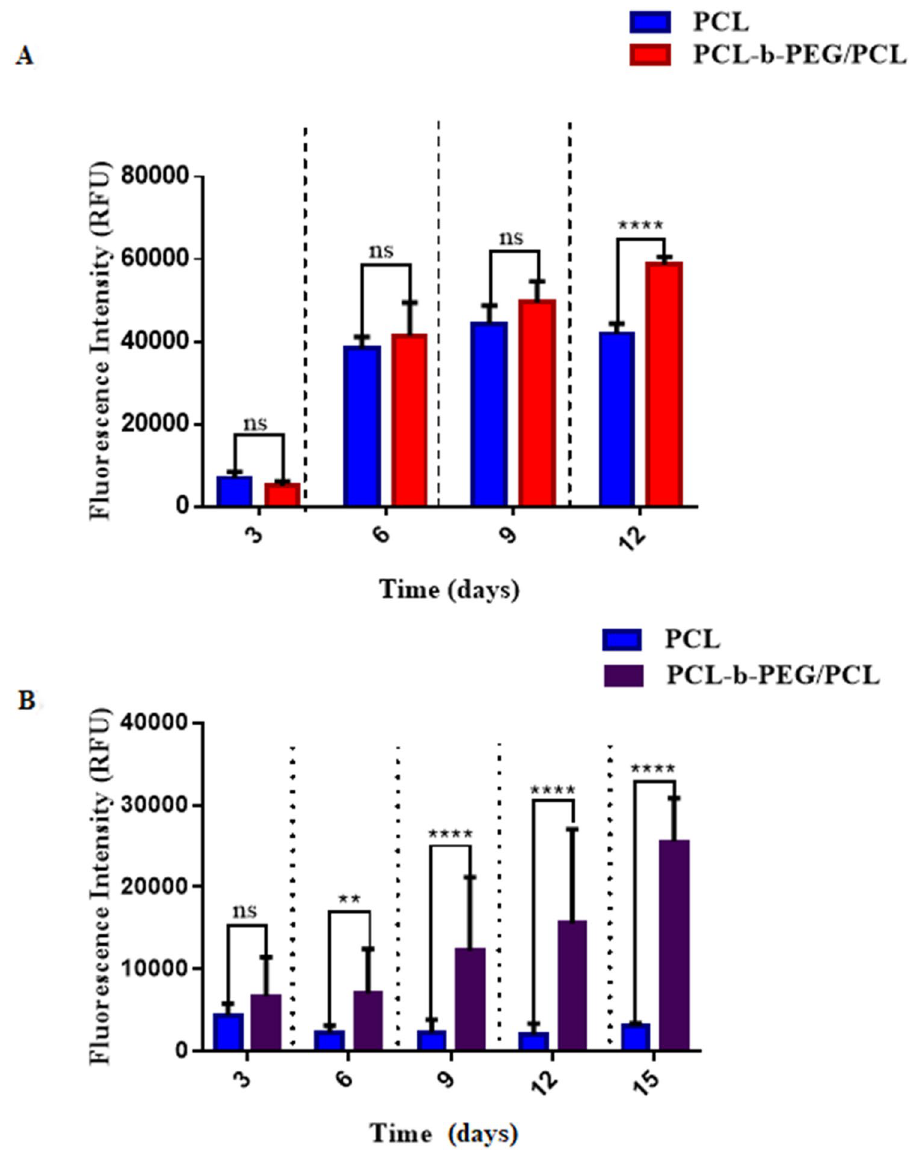
Fig. 2 Fibroblast metabolic activity when cultured on the scaffolds was assessed using AlamarBlue™. A Fluorescence readings indicating the metabolic activity of 3T3 GFP fibroblasts cultured on PCL and PCL-b-PEG/PCL scaffolds, over 12 days. B Fluorescence readings of metabolic activity of dermal human fibroblasts BJ6 cultured on PCL and PCL-b-PEG/PCL over 15 days of culture. Three independ- ent experiments carried out in triplicate (means ±